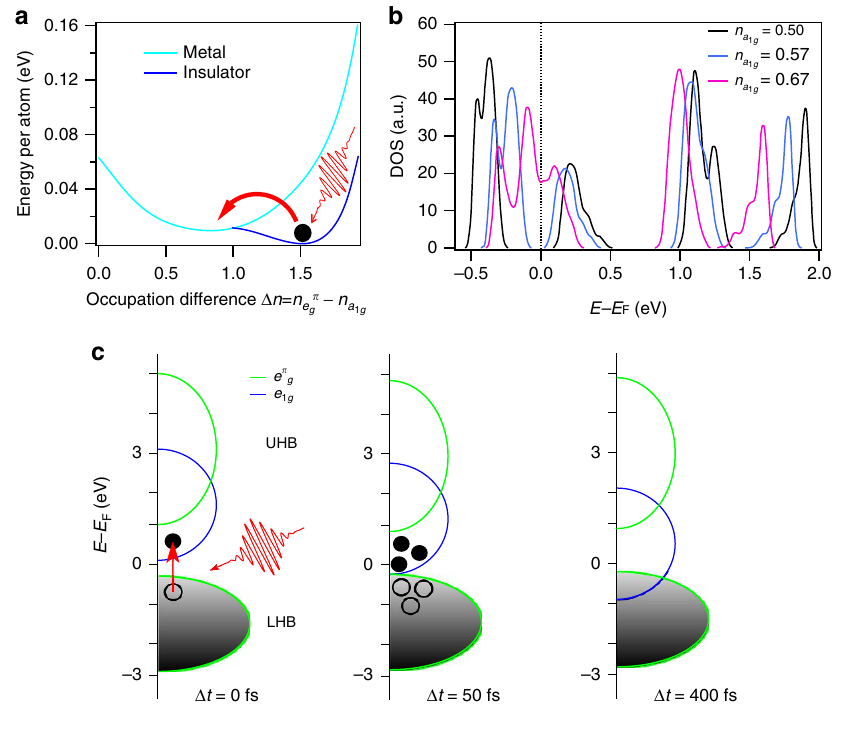
and a 1 g orbitals (the total occupancy g